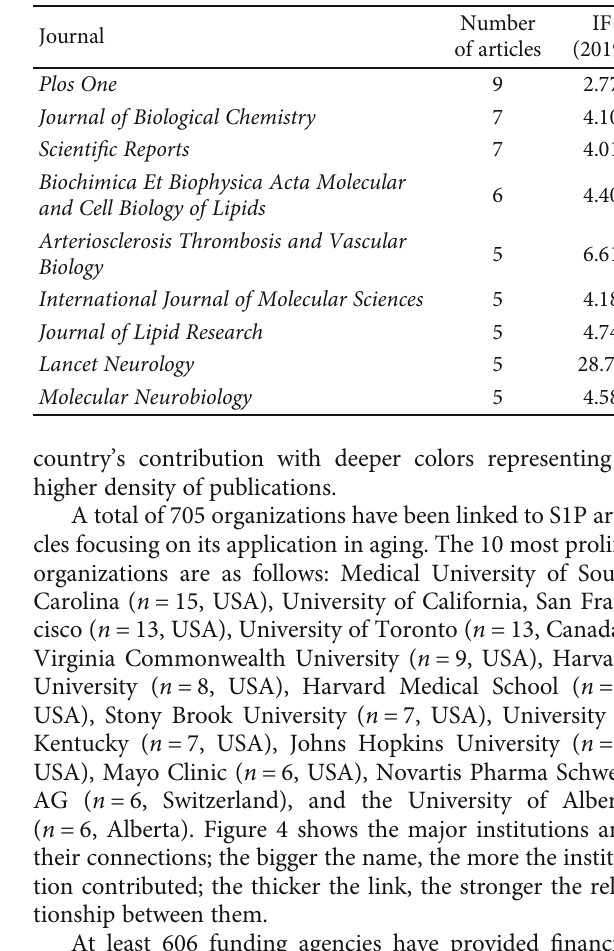
Table 1: Top 10 contributory